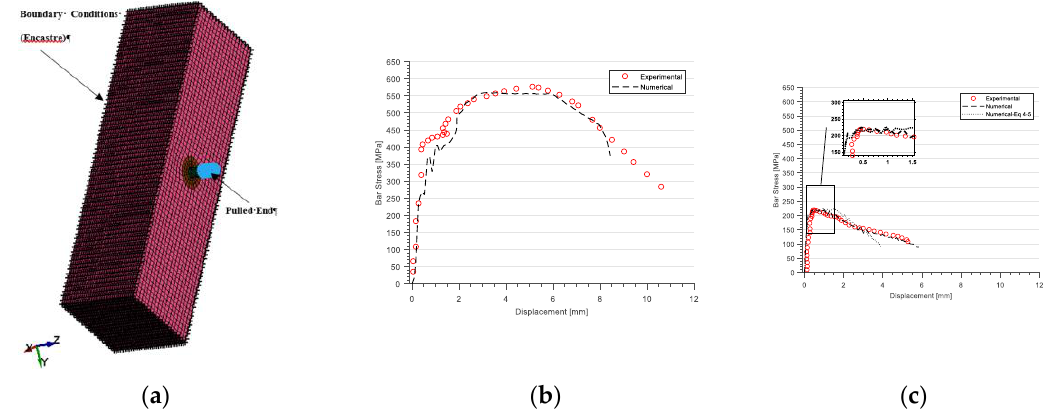
Figure 10. FE analysis of anchorage tests by Zhou et al. [11]: ( a ) model showing boundary conditions and pulled end; ( b , c ) bar stress vs. loaded-end displacements at 3.94 and 7.87 d b , respectively (recreated using data from Zhou et al. [11]).